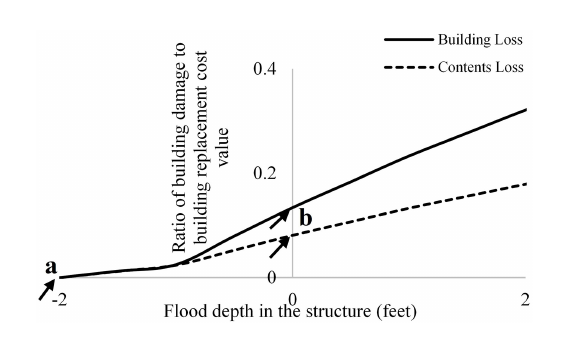
FIGURE2 Depiction of United States Army Corps of Engineers (2000) mean depth-damage function for a one-story, no-basement residential building, starting at flood depth of (a) − 2 feet (original function), and (b) 0